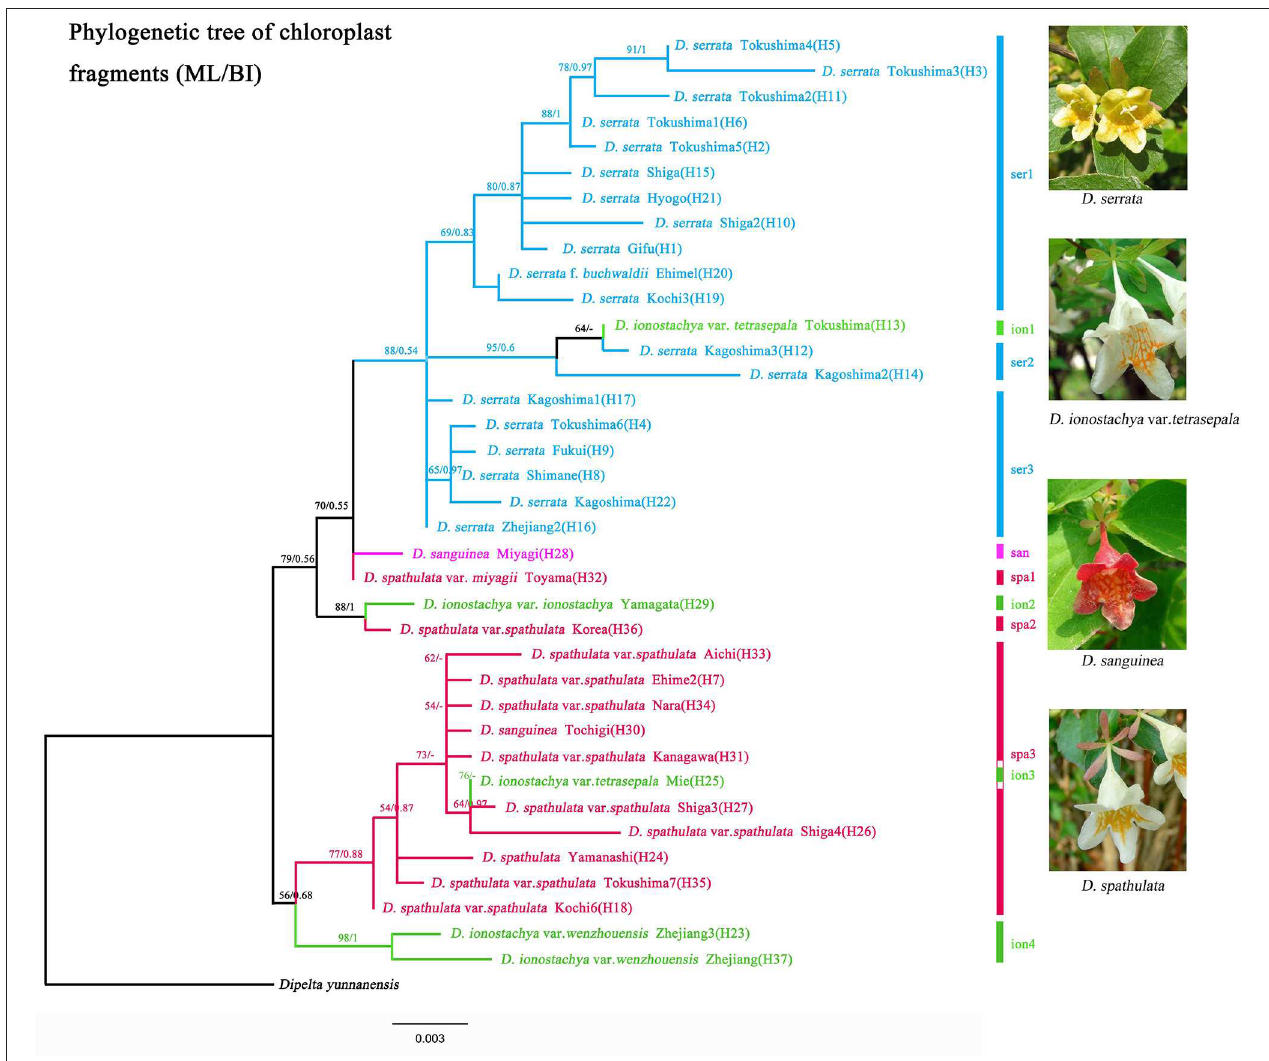
FIGURE 2 | Maximum Likelihood tree inferred from RAxML for 37 haplotypes in Diabelia based on concatenated sequences of chloroplast DNA ( trn H -psb A , rpl 32 -trn L) with Dipelta yunnanensis as the outgroup. Numbers associated with branches are ML bootstrap support values. Population migration direction inferred (a, b, and c) from haplotype phylogenetic tree of Diabelia